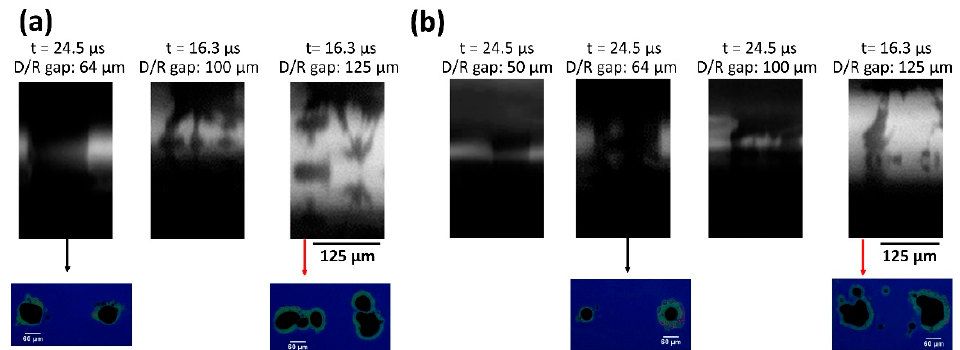
Figure 3. Still frame images extracted from videos acquired at 122,400 fps for a donor/receiver gap set at ( a ) 64 μ m, 100 μ m and 125 μ m (from left to right respectively) and from a donor layer thickness set by the film applicator at 100 μ m and using laser fluence of 1.4 J/cm 2 ; ( b ) 50 μ m, 64 μ m, 100 μ m and 125 μ m (from left to right respectively) and from a donor layer thickness set by the film applicator at 150 μ m and using laser fluence of 1.7 J/cm 2 ; Bottom row: Optical microscope images of laser-printed bumps on Si substrate at 1.4 J/cm 2 ( a ) and 1.7 J/cm 2 ( b ) for donor/receiver gap set at: 65 μ m and 125 μ m.